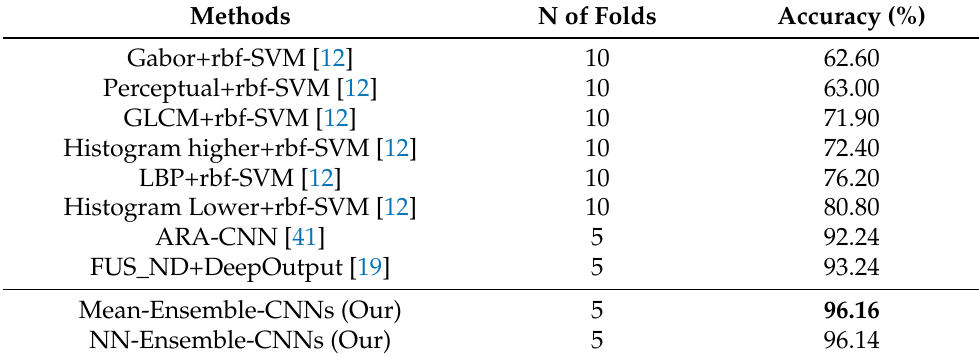
Table 7. Comparison between our approaches and the state-of-the-art methods on Kather-CRC- 2016 database.